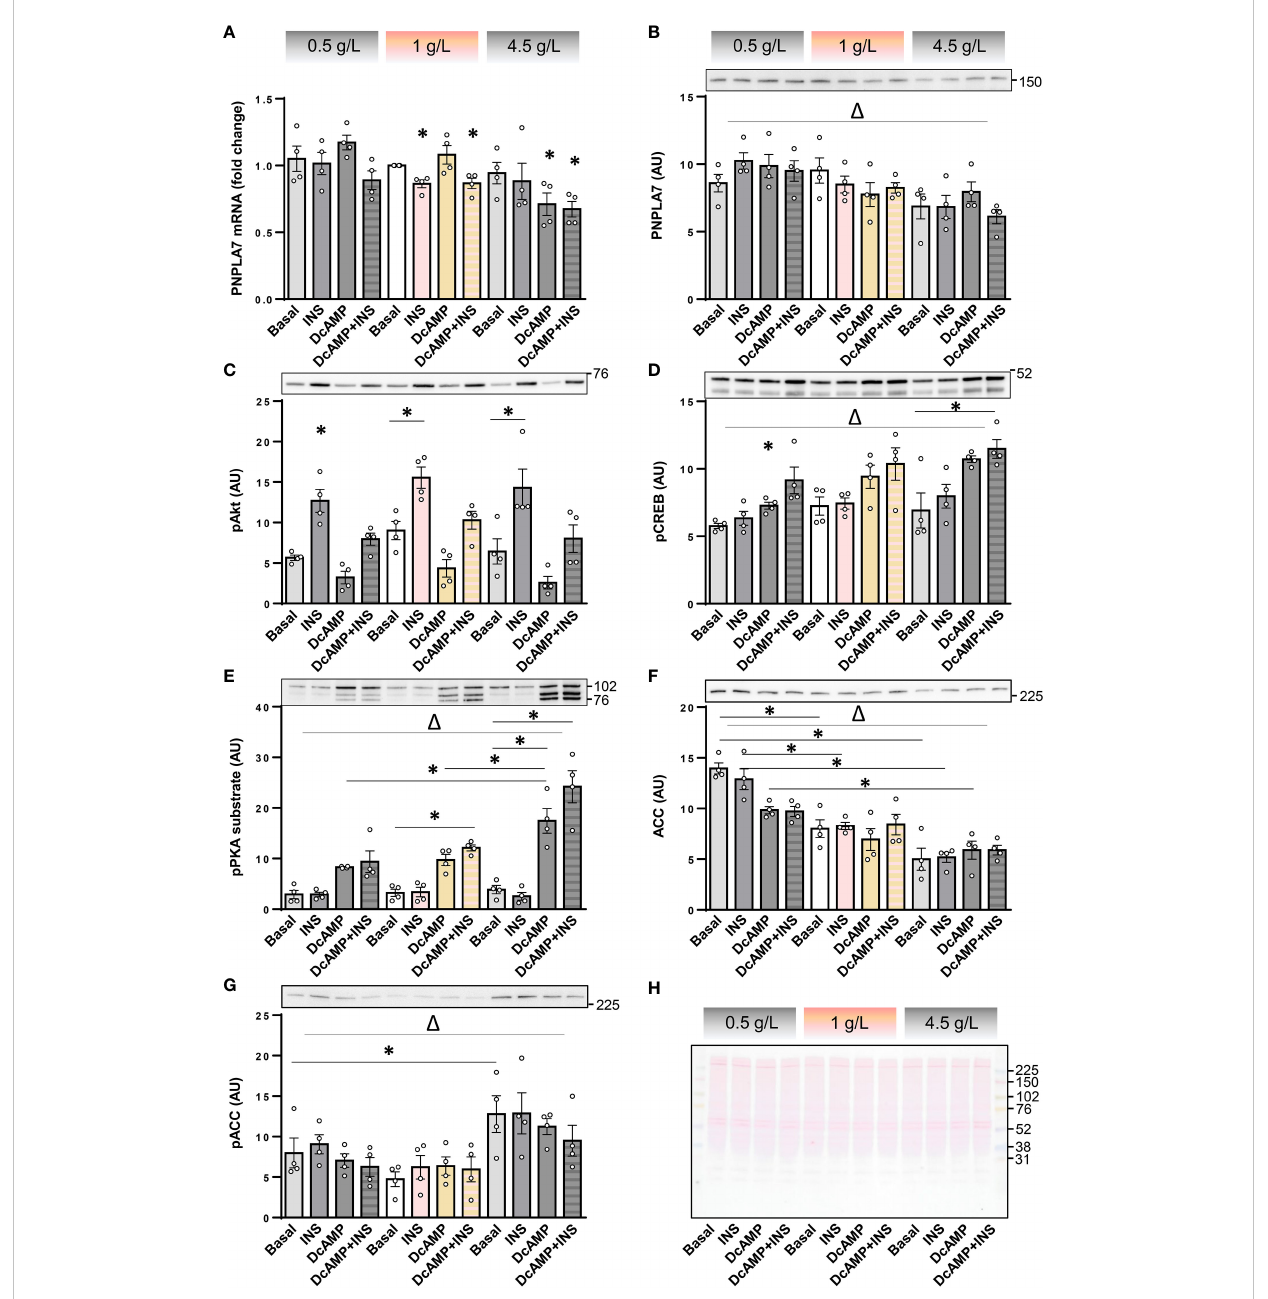
FIGURE 4 Effect of insulin, dibutyryl-cAMP, and glucose on the expression of PNPLA7 in cultured myotubes. (A – G) Human skeletal muscle cells were differentiated for 8-10 days in Advanced MEM with 2% FBS. For the last 16 h of the experiment cells were grown in serum starvation DMEM with low (0.5 g/L), normal (1 g/L), or high glucose concentration (4.5 g/L) (marked at the top with the grey-pink-grey colour code), and exposed at the same time to insulin (0.1 µg/mL; INS) and/or dibutyryl-cAMP (200 µM; DcAMP), or vehicle (Basal). (A) Transcript levels of PNPLA7 were measured by qPCR and are presented as geometric mean of expression ratios against two reference genes, 18S rRNA and ACTB. (B – G) Protein levels of (B) PNPLA7 and markers of activity of metabolic pathways/metabolic status, (C) phospho-Akt Ser 473 , (D) phospho-CREB Ser 133 , (E) phospho-PKA substrate, (F) ACC, and (G) phospho-ACC Ser 79 , were assessed by immunoblotting. (H) A representative Ponceau-stained membrane. Actin blots, which were used as an additional loading control are shown in the corresponding Supplementary Figure. Results are means with SEM (n = 4, including one donor from Sigma-Aldrich, Merck). *p < 0.05 vs. Basal-0.5 g/L glucose or as indicated. D p < 0.05 two-way ANOVA between different glucose